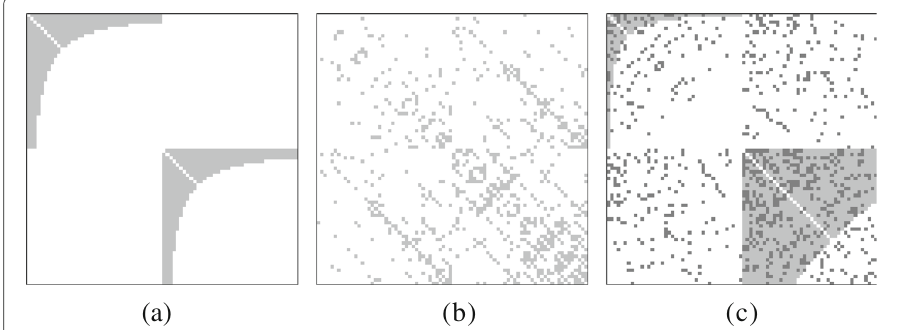
ordering the communities. a input graph b R-MAT result c fitted